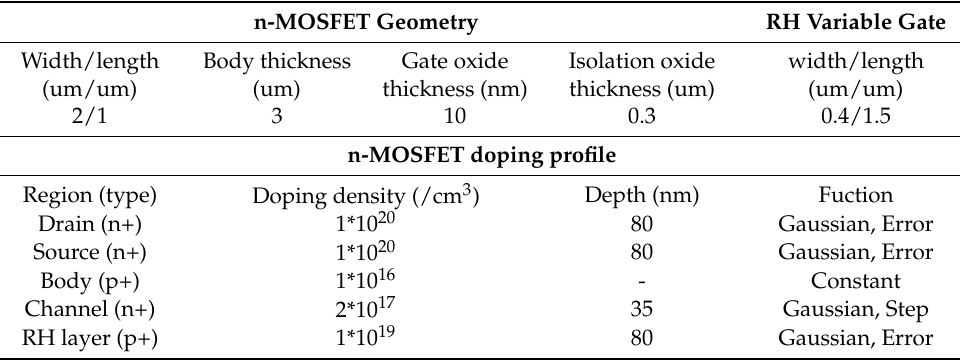
Table 2 . Geometry and doping profiles of the RH V-gate n-MOSFET.